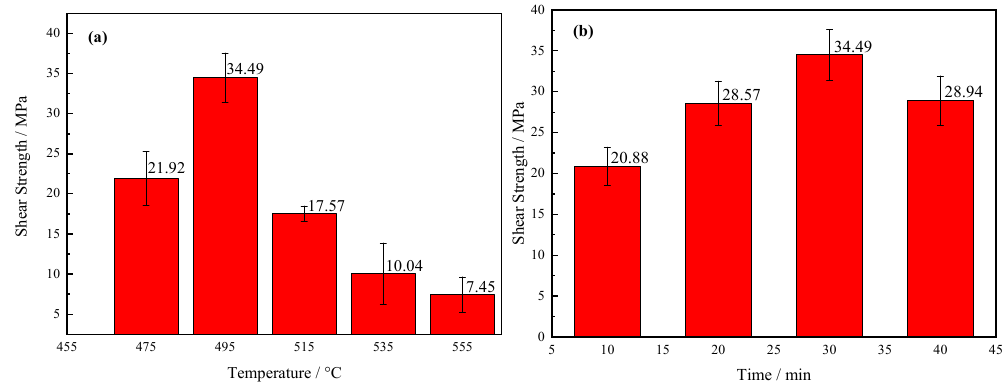
Figure 14. Shear strength of the brazing joints as a function of: ( a ) brazing temperature; ( b ) brazing time.